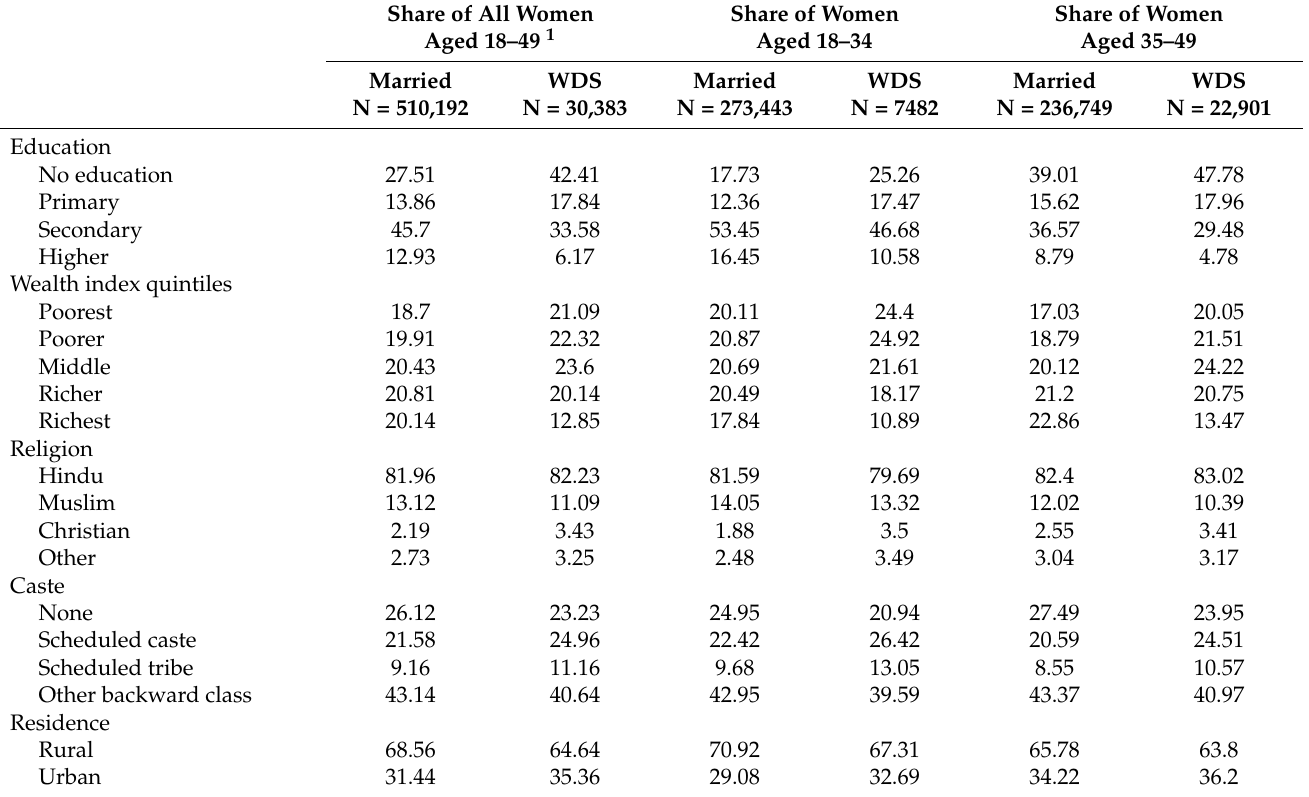
Married Widowed/divorced/separated Figure 1. Tobacco use prevalence by sociodemographic characteristics and marital status. Estimates were obtained using complex survey weights. The differences in tobacco use prevalence between married and widowed/divorced/separated women were statistically significant across all sociodemographic groups except for “age 18–34: other religion”. Table 2. Descriptive statistics of the study participants by marital disruption. Share of All Women